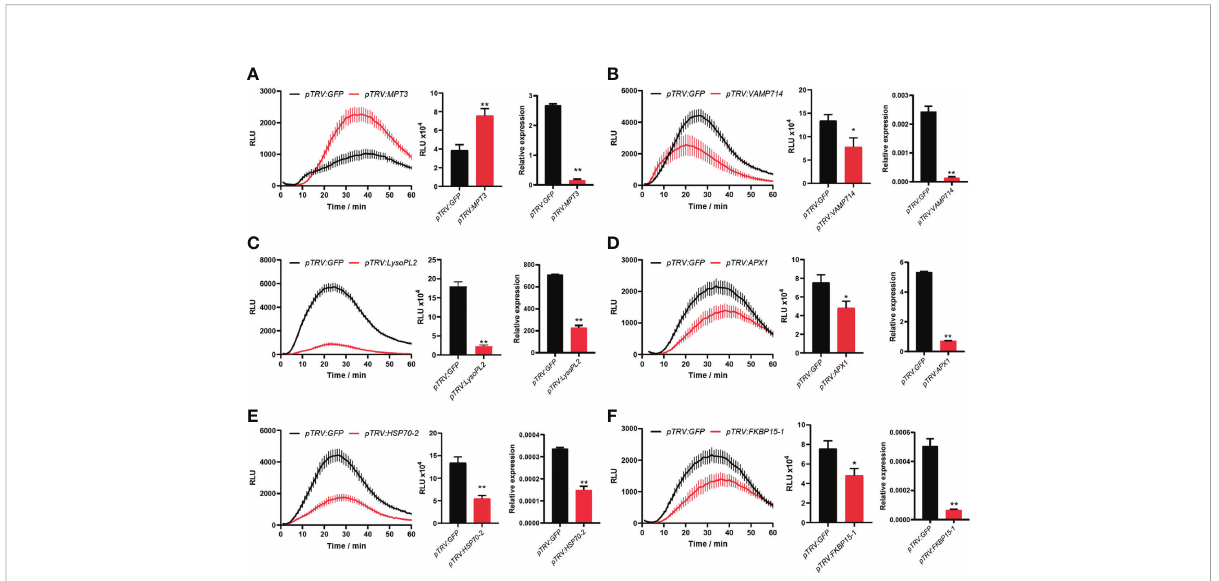
FIGURE 5 Six novel candidate DEPs were found involved in PTI responses. After virus-induced gene silencing (VIGS) of MPT3 (A) , the ROS production was signi fi cantly up-regulated, while after VIGS of VAMP714 (B) , LysoPL2 (C) , APX1 (D) , HSP70-2 (E) and FKBP15-1 (F) , the ROS production was signi fi cantly down-regulated. The bar charts show the total count of ROS accumulation and silencing ef fi ciency of VIGS. Independent experiments have been conducted three times with similar results. Student ’ s t -test was used for the statistical analysis. Error bars stand for SEM, * P < 0.05 and ** P <